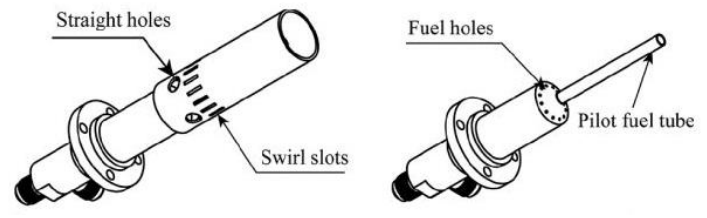
Figure 4. Capstone C30 injector [46].